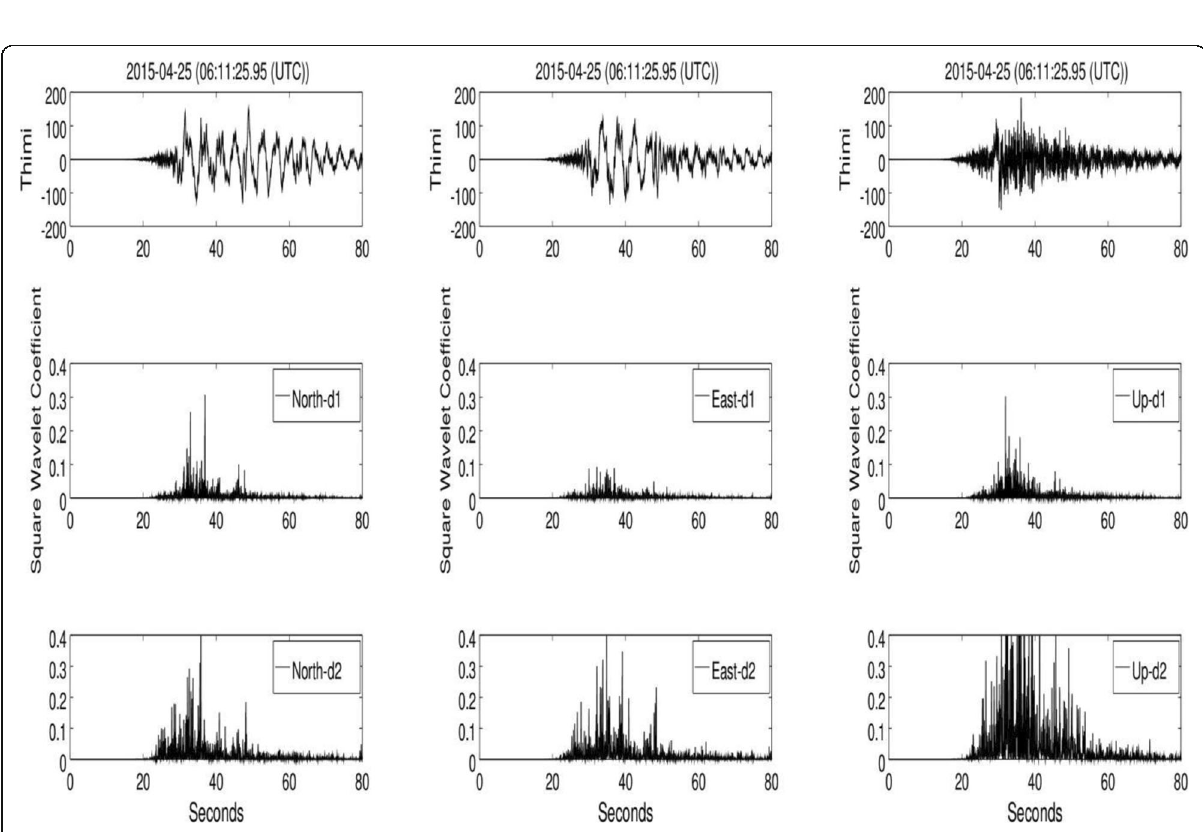
Fig. 13 Square wavelet coefficient dj (j = 1 and 2) of ground motion in NS, EW and Vertical direction observer at THM